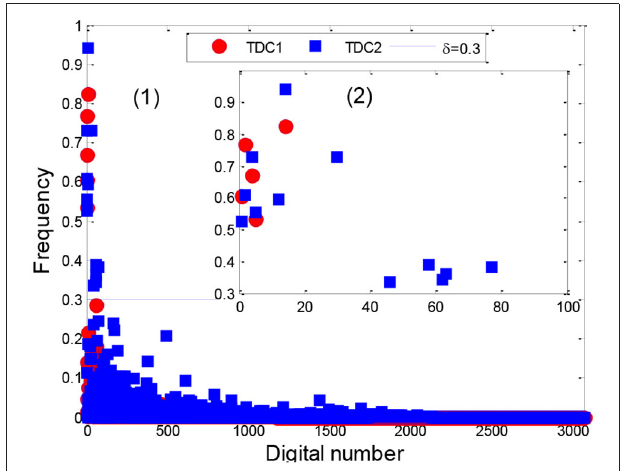
FIGURE 8 | Distribution of TDCs for 800 core patients.